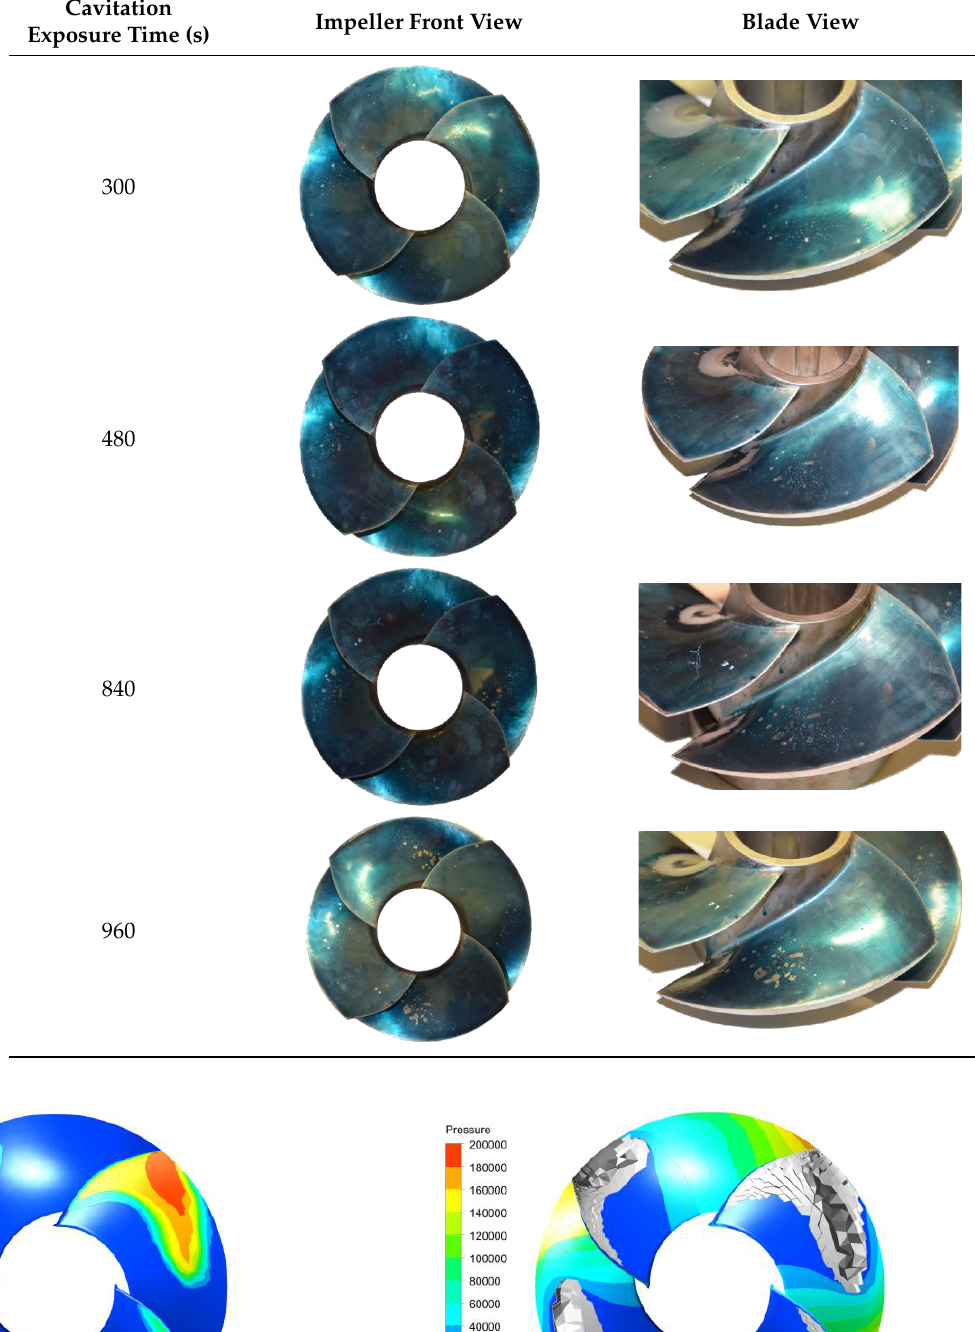
Table 3. Development of cavitation erosion zone in the rimless impeller ( Q = 0.3 × Q BEP , NPSH = 3.65 m).